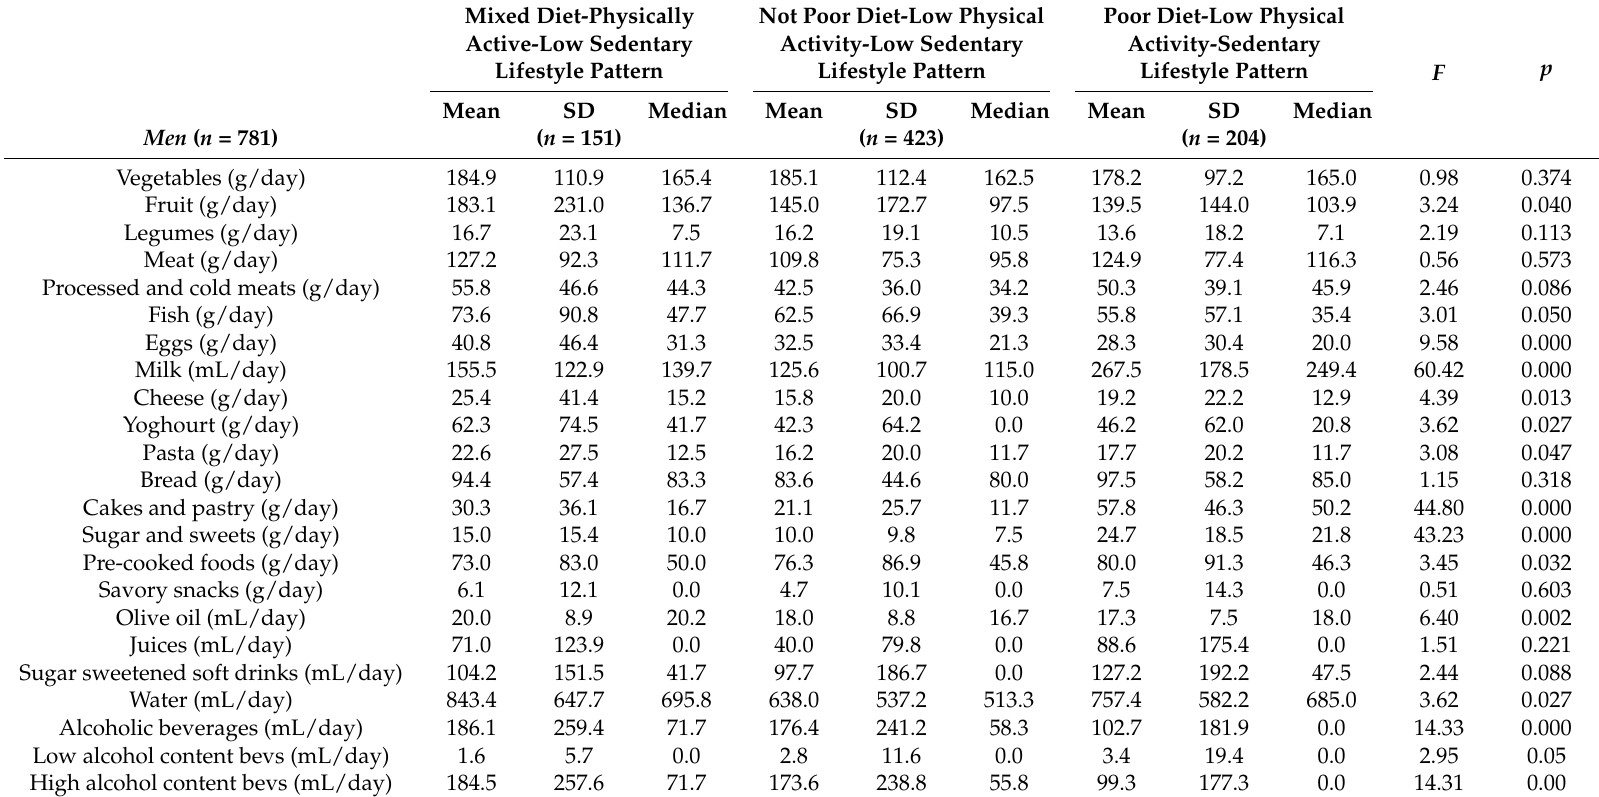
Table 3. Consumption of selected food groups and beverages by lifestyle pattern in men and